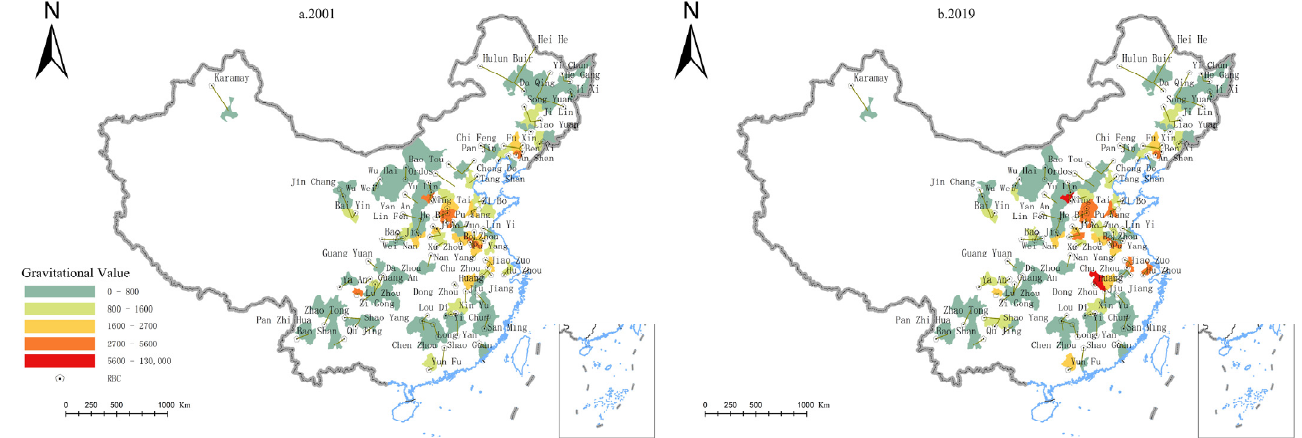
Figure 3. Spatial and temporal evolutionary characteristics of geographical proximity.